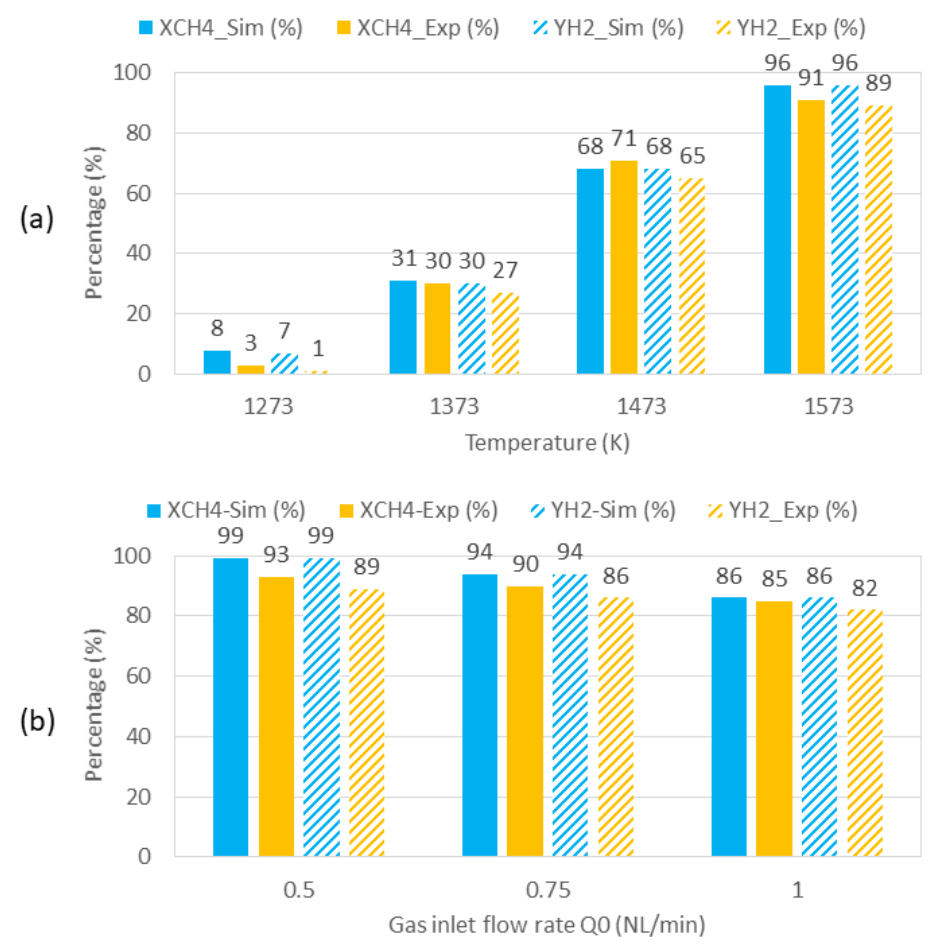
Figure 7. Comparison of numerical and experimental results in terms of methane conversion and hydrogen yield as a function of ( a ) operating temperature and ( b ) gas inlet flow rate.